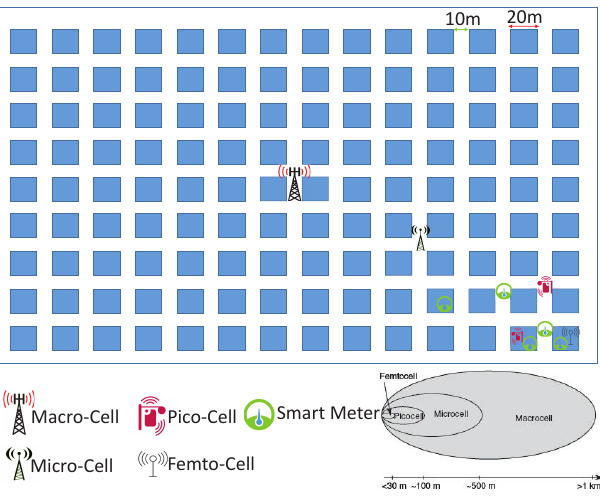
Figure 1. Small Cell Deployment